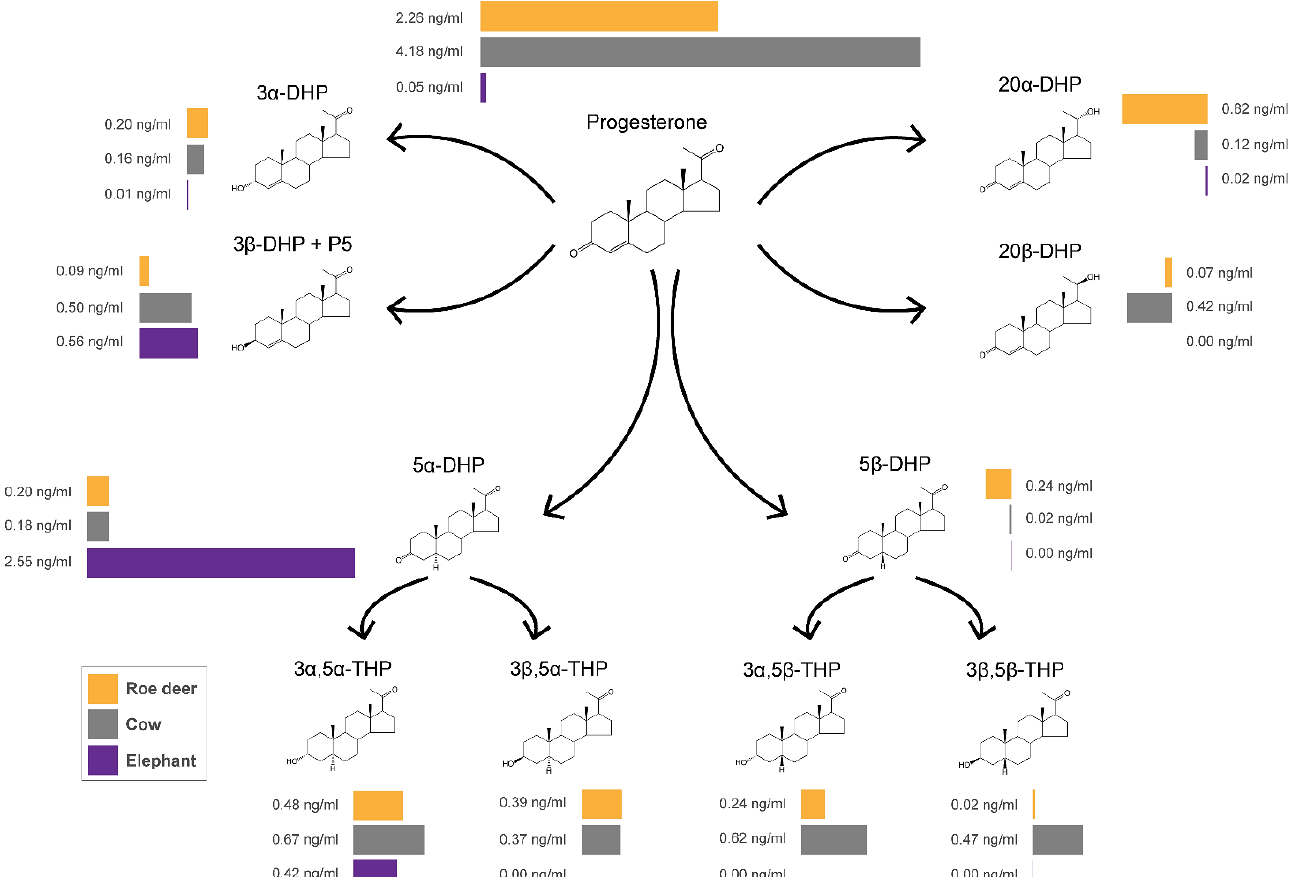
Figure 1. Plasma concentration of P4 and its metabolites. The concentration of each progestogen is indicated in ng/ml. The yellow, grey and purple bars represent the progestogen concentrations in the roe deer during diapause, the luteal phase in the cow [15], and late pregnancy in the elephant (unpublished own data) The profiles of all progestogens, except 3β,5α-THP, did not significantly change with developmental progression defined as either sampling date or embryo size (Figure 2 and Supplementary data I). There was a negative correlation between P4 and its metabolites 5β-DHP, 3β,5β-THP and 3α,5β-THP (Figure